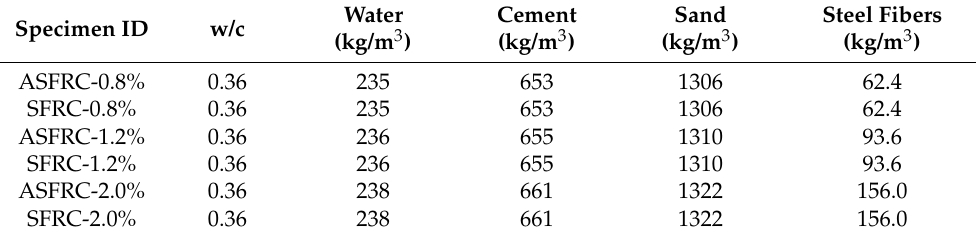
Table 1. Mix proportions of steel fiber reinforced cement-based composites.